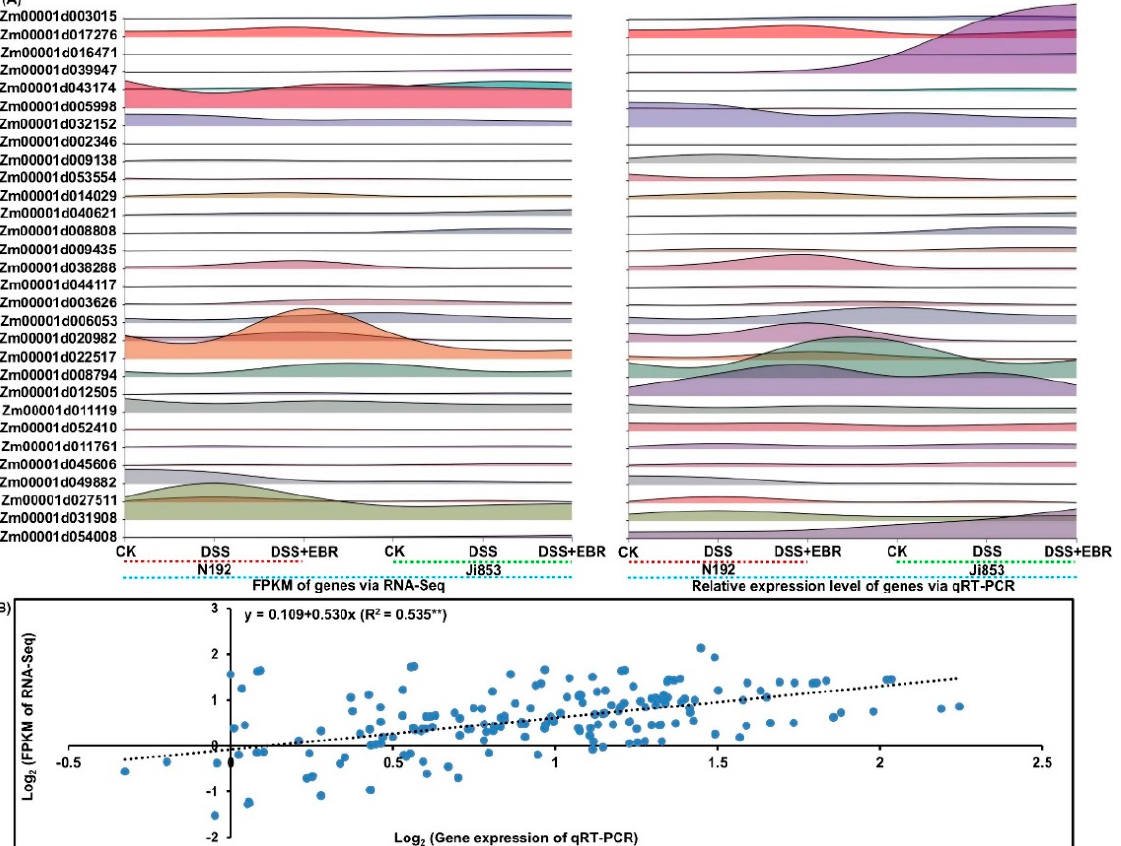
Figure 4. The quantitative real–time (qRT–PCR) expression analyses of 30 selected genes of N192 and Ji853 mesocotyls in CK, DSS, and EBR signaling, respectively. Interactive layered area map for 30 selected DEGs comparisons by qRT–PCR and RNA—Seq were performed using by a free online Genescloud tool (https://www.genescloud.cn; accessed on 12 December 2021) ( A ). Correlation between qRT-PCR and RNA-Seq data (** p < 0.01; ANOVA) ( B